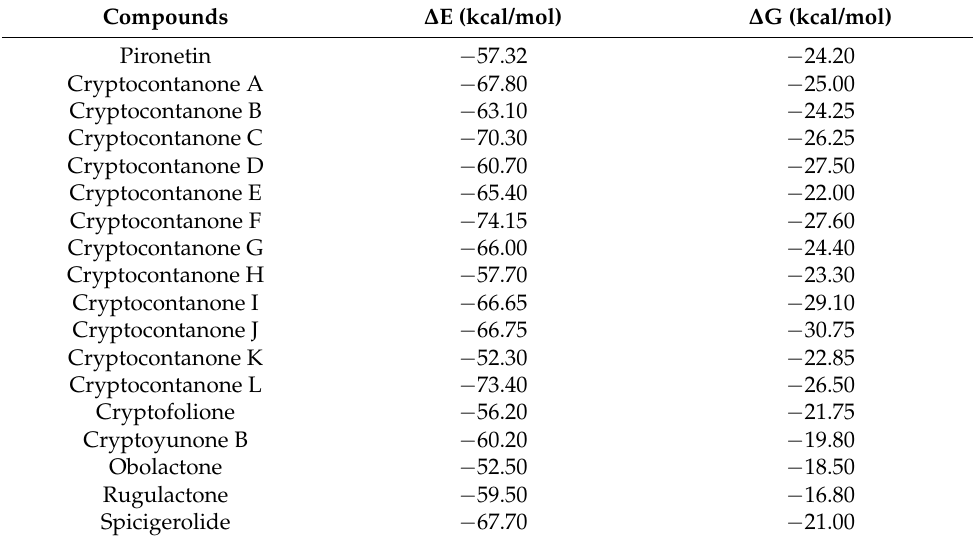
Table 1. Calculated potential energy of interaction ( ∆ E) and free energy of hydration ( ∆ G) for the interaction of the indicated natural products with